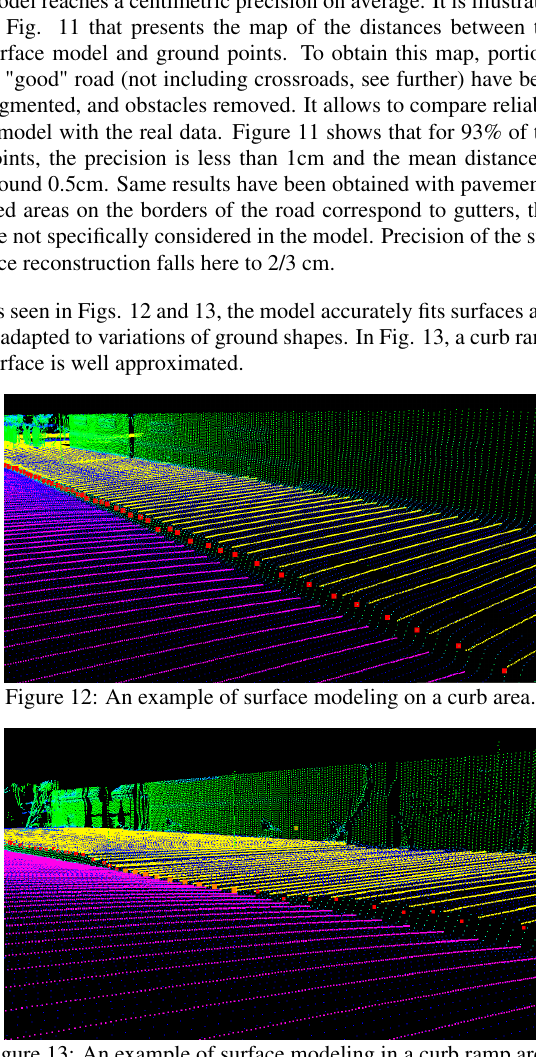
Figure 10: Result of the prediction/estimation road side detection model with three interactions on a part of Rue D’Assas, in the 6th district of Paris (corresponding to 200 meters of road). The upper image is the results of curb and curb ramp detection, the lower one also presents the LIDAR data. In red, the detected curbs and in orange, the detected curb ramps. Purple squares correspond to interaction caused by a curb ramps occurring in bends. The green square correspond to an occlusion that happens in the end of a road side chicane.